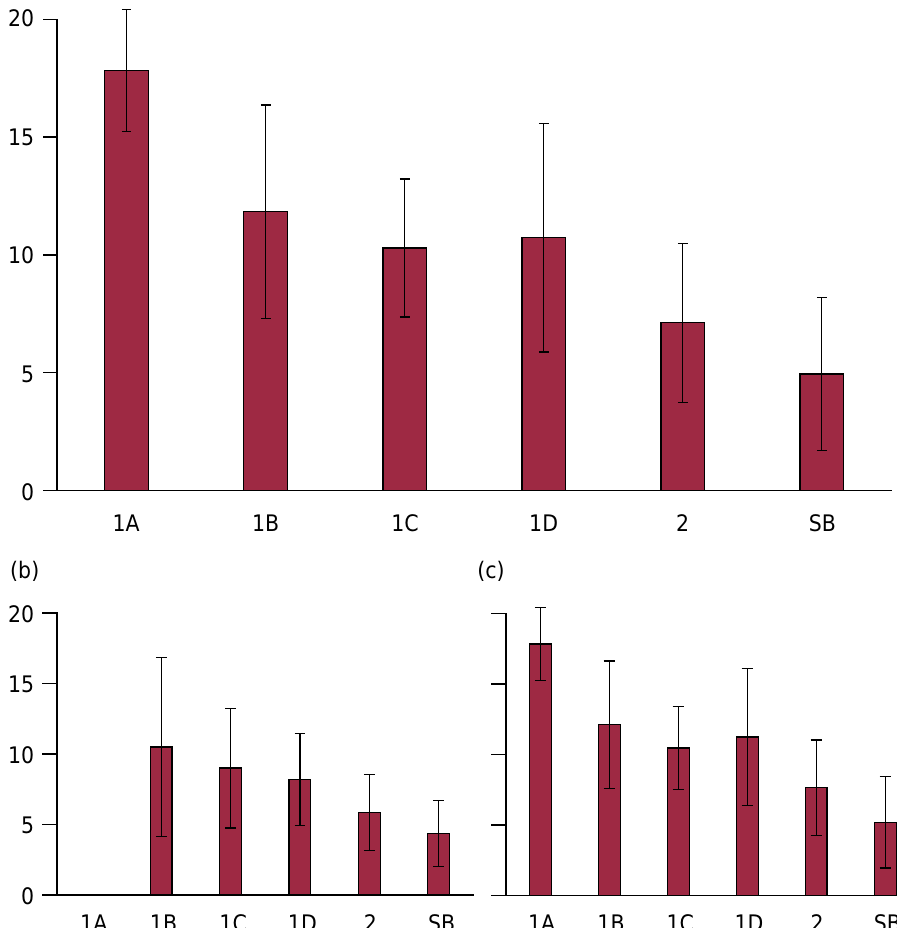
Figure 3. Web of Science H-Index (H-WoS), by class of PQ fellowship and non-fellows (SB), for all researchers regardless of gender (a) and by gender women (b) and men (c), in CNPq Call 2018. Vertical bars depict standard